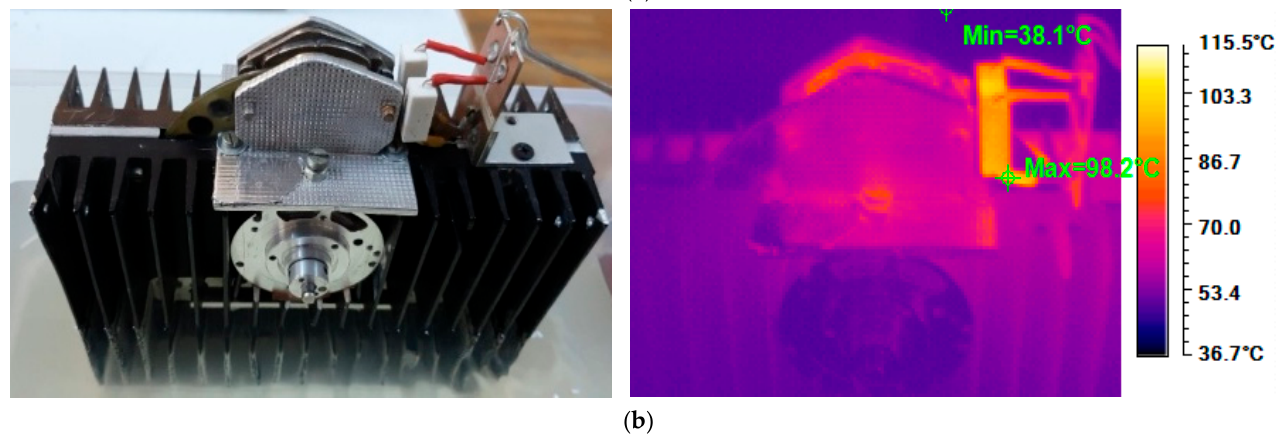
Figure 11. Thermographic maps showing the heat source at different temperatures. ( a ) speed 40 rpm, ( b ) speed 30 rpm. ( b ) speed 30 rpm.